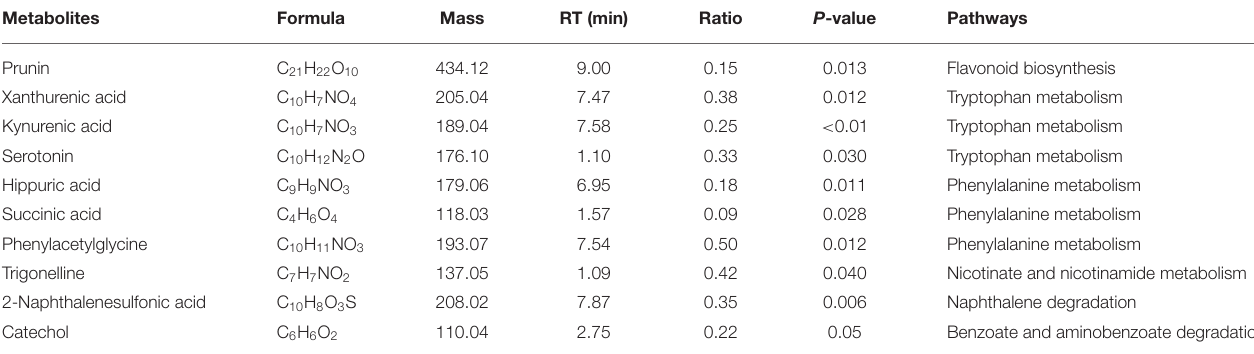
TABLE 3 | Summary of the candidate biomarkers between HMIP and CCl 4 groups. Metabolites